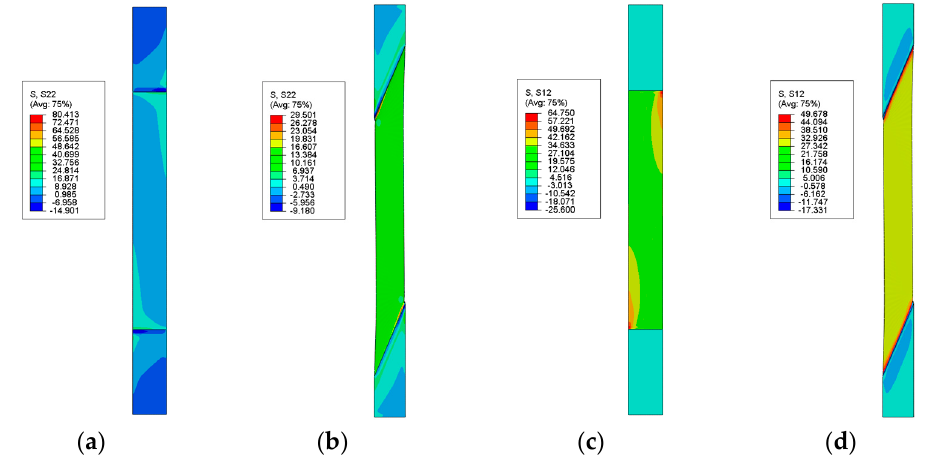
Figure 4. Stress contour plots of 15° off-axis tension specimens: ( a ) 𝜎 (cid:3052) of specimen with regular end-tabs; ( b ) 𝜎 (cid:3052) of specimen with oblique end-tabs; ( c ) 𝜏 (cid:3051)(cid:3052) of specimen with regular end-tabs; ( d ) end-tabs; ( b ) σ y of specimen with oblique end-tabs; ( c ) τ xy of specimen with regular end-tabs; ( d ) τ xy 𝜏 (cid:3051)(cid:3052) of specimen with oblique end-tabs. of specimen with oblique